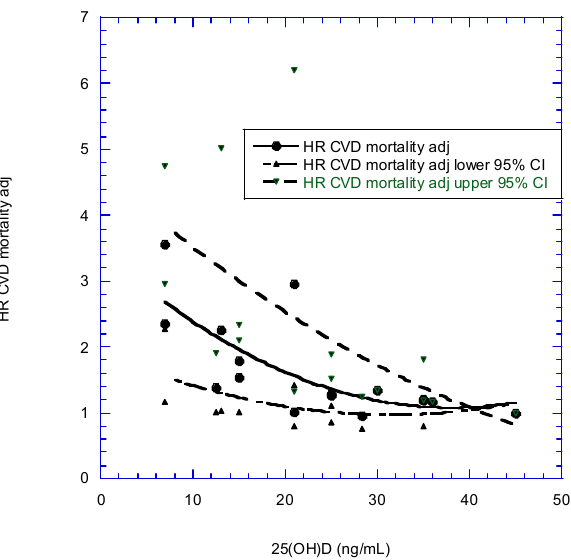
Figure 1. Hazard ratio (HR) and 95% confidence interval (CI) for CVD mortality according to mean serum 25-hydroxyvitamin D [25(OH)D] concentrations for data from four prospective observational studies.